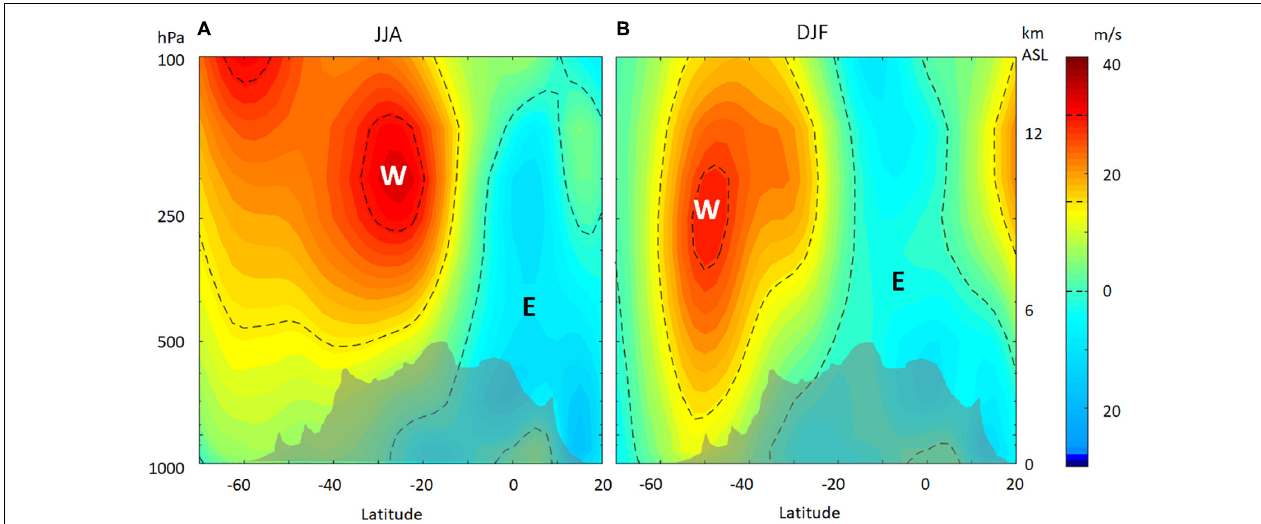
FIGURE 2 | Cross-section of long-term-mean (1981–2020) zonal wind (U) at 70 ◦ W for (A) austral winter (JJA) and (B) summer (DJF). Gray area indicates mean Andes height averaged at 80–60 ◦ W. Contours indicate U = 0, 15, and 30 m/s. Data from NCEP-NCAR Reanalysis.